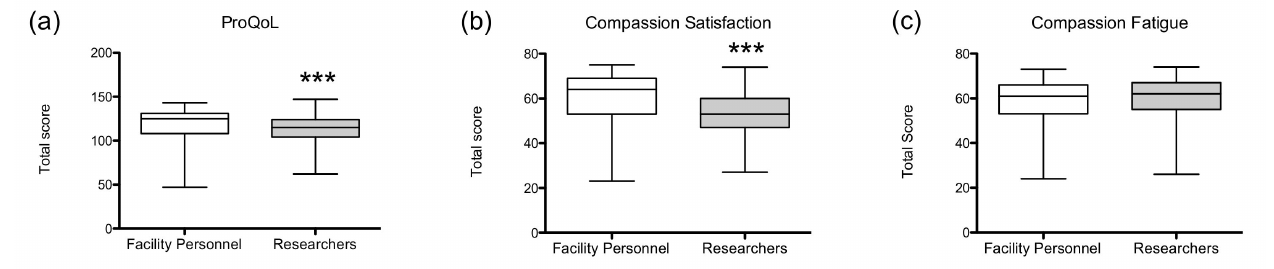
Figure 1. Animal-facility personnel versus researchers ( a ) professional quality of life scale (max 150), ( b ) compassion satisfaction (max 75) and ( c ) compassion fatigue (max 75) subscale scores. Data are presented as group median (min to max). *** p <